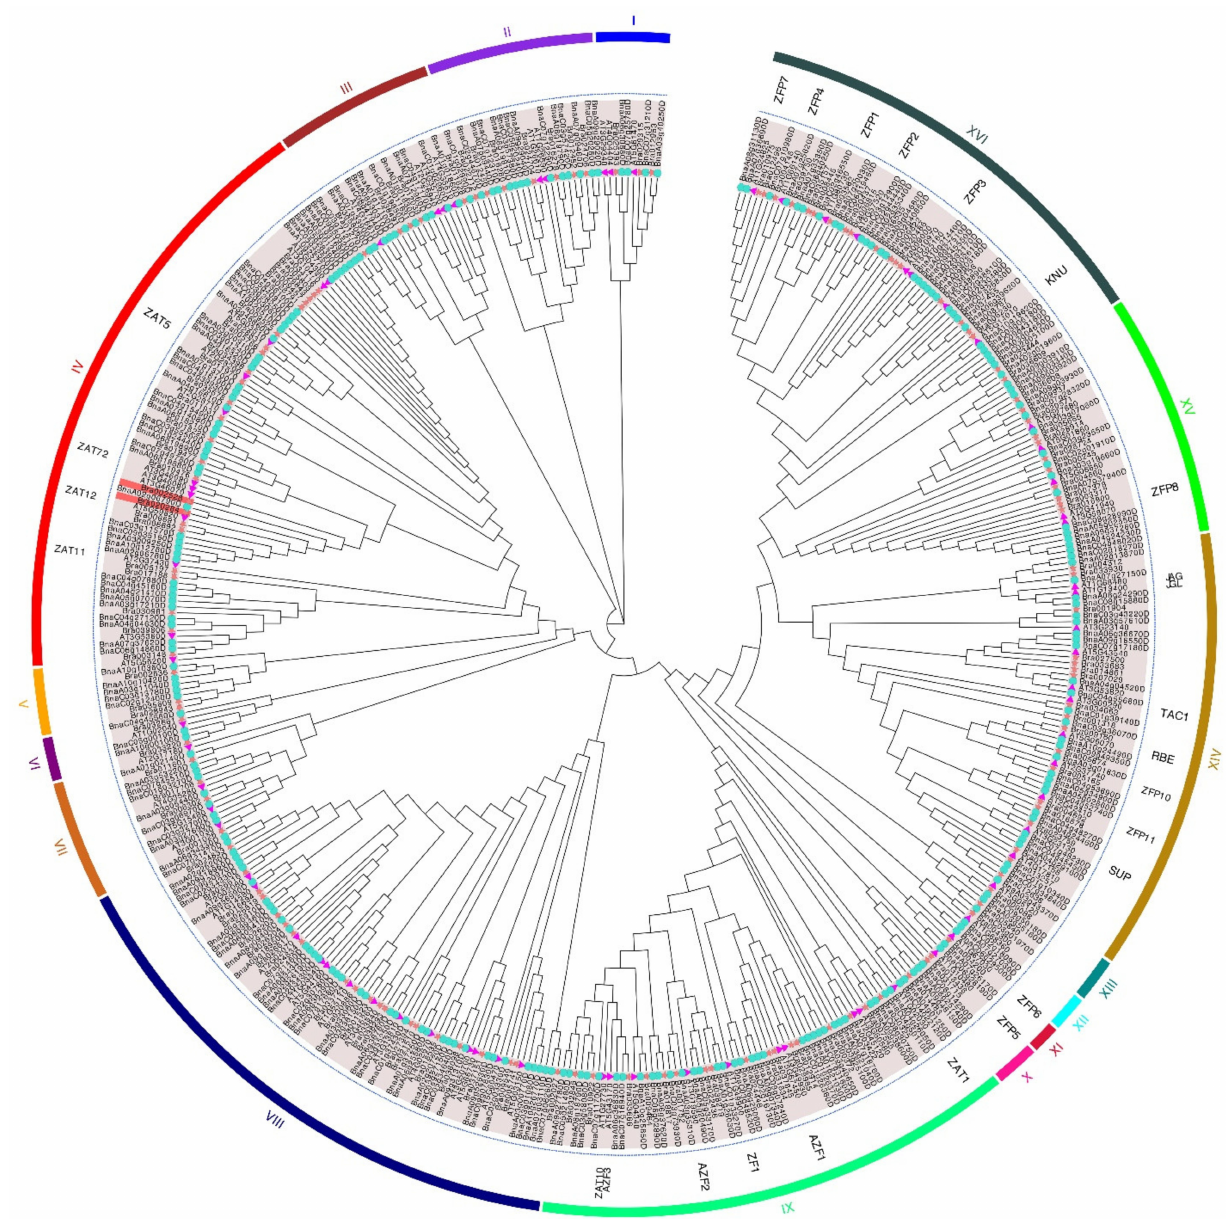
Figure 2. Phylogenetic tree of the C2H2 ZFP family. The 16 subfamilies are colored differently. Red stars represent B. rapa , blue circles represent B. napus, and purple triangles represent Arabidopsis. The abbreviations indicate the ZFP gene family known in